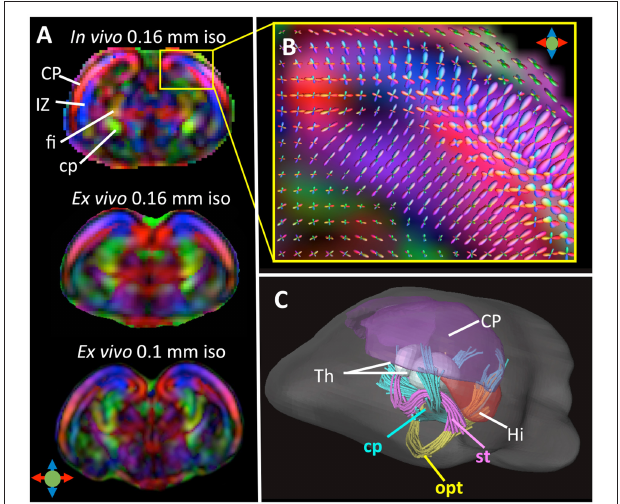
FIGURE 3 | (A) Top: A coronal DTI colomap of an embryonic mouse brain at embryonic day 17 (E17) acquired in vivo using the localized imaging approach at an isotropic spatial resolution of 0.16 mm. Mid and bottom: comparable ex vivo DTI colormaps of an E17 embryonic mouse brain acquired at 0.16 and 0.1 mm isotropic resolution. (B) A local fiber orientation distribution (FOD) map showing radially and tangentially distributed microstructures in the cortical plate and intermediate zone, overlapped on a zoomed-in region from (A) . (C) Early white matter tracts reconstructed from the in vivo dMRI data including the cerebral peduncle (cp), optic tract (opt), and stria terminalis (st). Also shown here are several gray matter structures: cortical plate (CP), hippocampus (Hi), and thalamus (Th). The color scheme used in the DTI colormaps and TDI are: red: left-right; blue: ventral-dorsal; green: rostral-caudal, as indicated by the color arrows in (A) . The images in this figure are modified from Wu et al. (2015) with